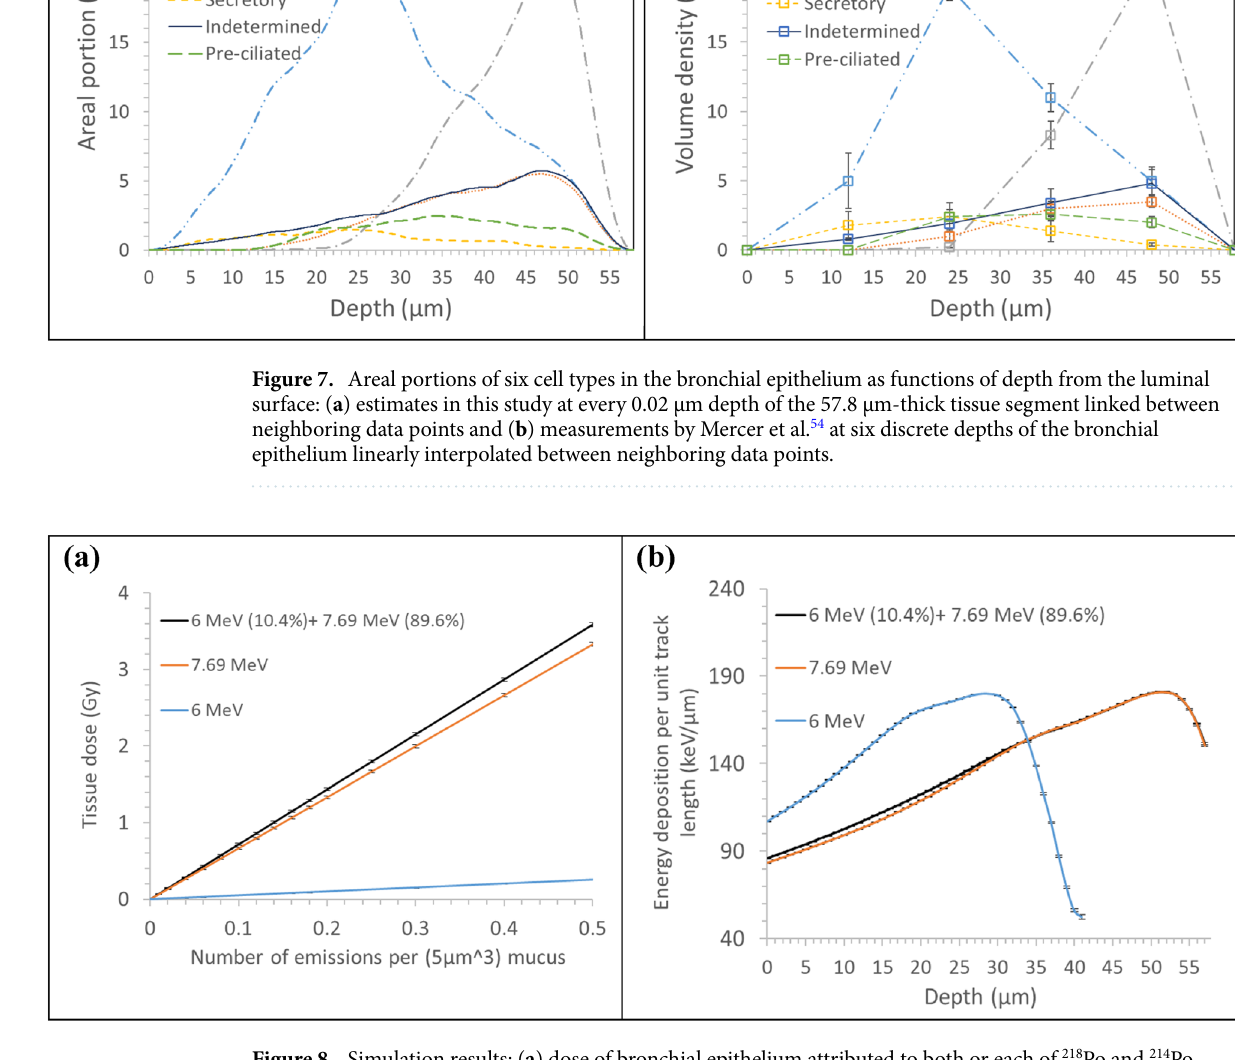
Figure 8. Simulation results: ( a ) dose of bronchial epithelium attributed to both or each of 218 Po and 214 Po emitting varied numbers of alpha particles in a 5 µ m 3 ( 1 µ m × 1 µ m × 5 µ m ) section of the mucous layer and ( b ) average energy depositions by alpha particles per unit length that vary in the depth in the tissue segment. Each bar indicates one standard deviation of the mean